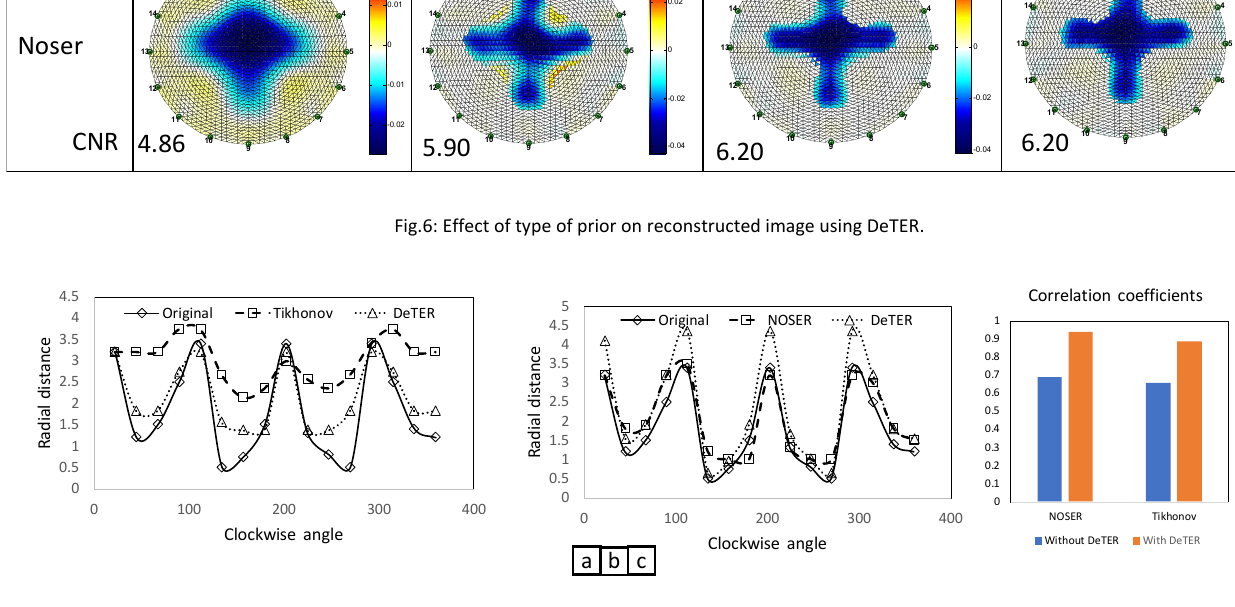
Fig.7: Plots of shape descriptor function for original and reconstructed images without and with DeTER (3rd iteration) using (a) Tikhonov and (b) NOSER prior (c) comparison of correlation coefficients for (a) and